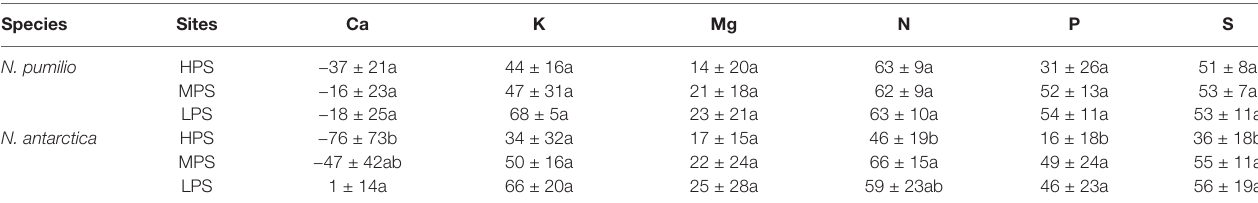
For each species, different letters for the same nutrient indicate significant differences (P < 0.05) between sites. HPS, highly productivity site; MPS, medium productivity site; LPS, low productivity